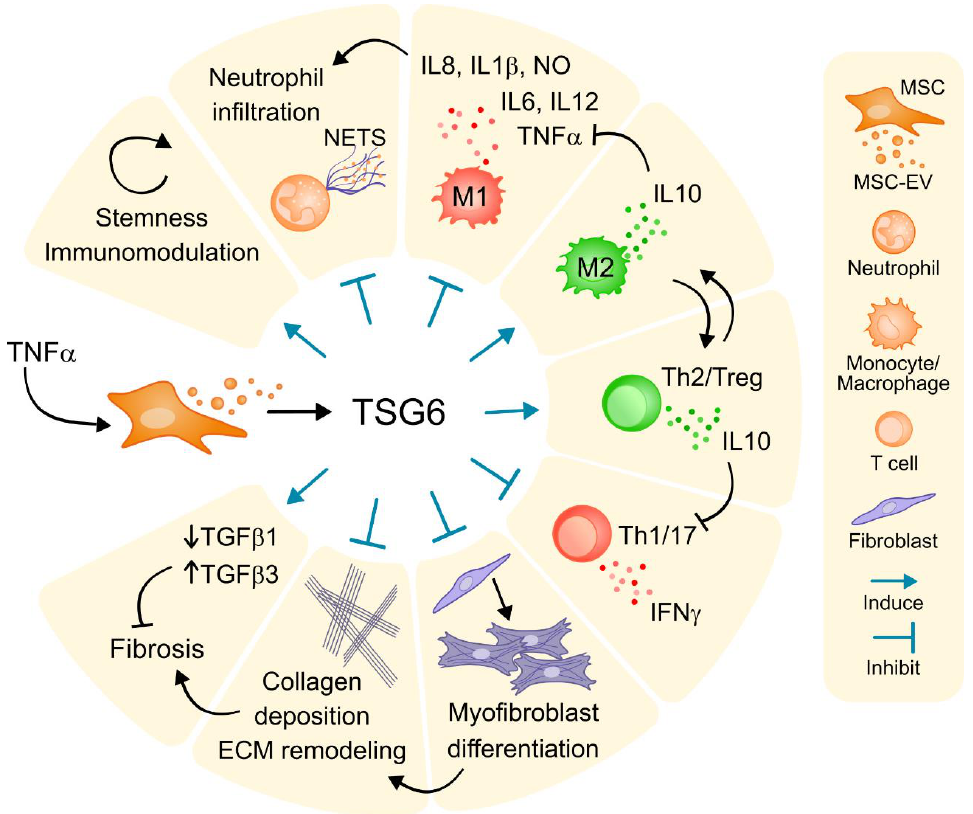
Figure 1. Summary of actions attributed to TSG-6, secreted by MSC and contained also in MSC-EV upon TNFα stimulation. In specific, TSG-6 can induce proliferation, stemness and increase in the immunomodulatory functions of MSC. TSG-6 reduces inflammation and switches on tissue repair by mechanisms such as: reducing neutrophil infiltration and activation; inhibiting inflammatory M1 towards M2 polarization of monocytes; inducing regulatory T cells; and reducing fibrosis. ECM: extracellular matrix; IFNγ: interferon gamma; IL: interleukin; MSC: mesenchymal stromal cell; MSC-EV: MSC-derived extracellular vesicles; NETS: neutrophil extracellular traps; NO: nitric oxide; TGF β : transforming growth factor β ; TNFα: tumor necrosis factor alpha; Treg: regulatory T cell; TSG-6: TNF - stimulated gene 6 protein.